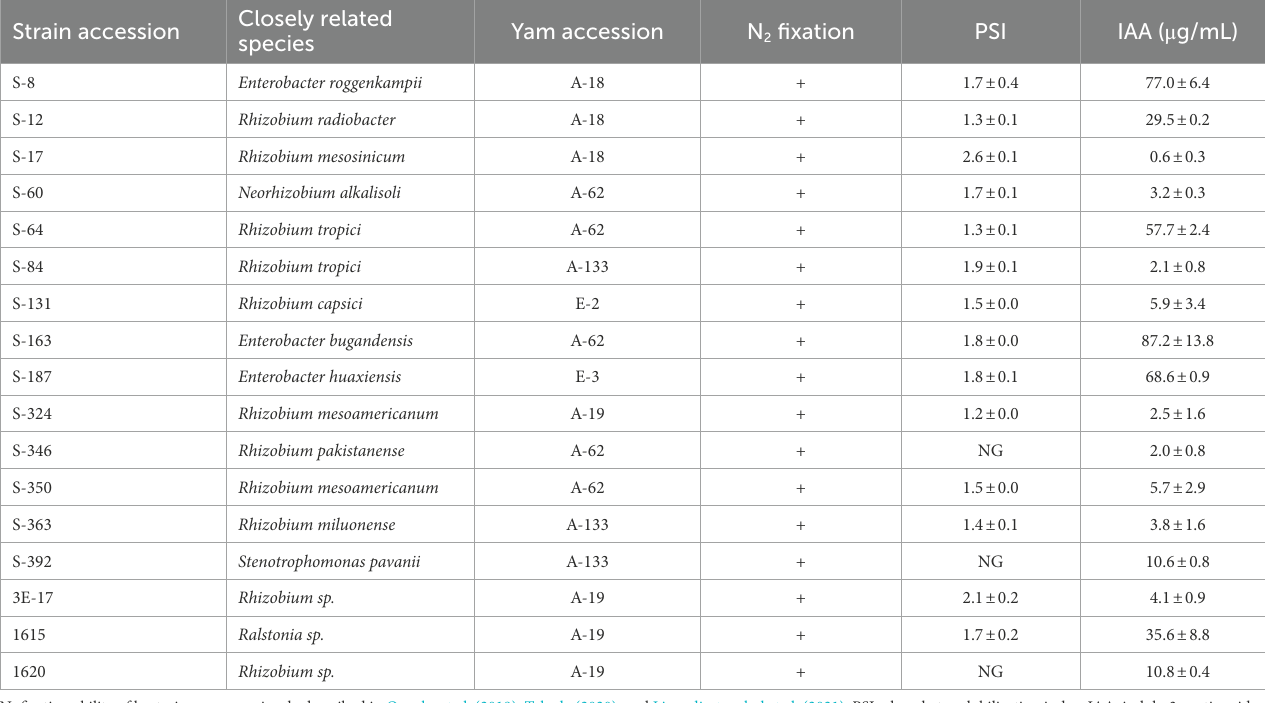
TABLE 2 Effect of inoculation on growth and nitrogen content of water yam cv. A-19. WAP